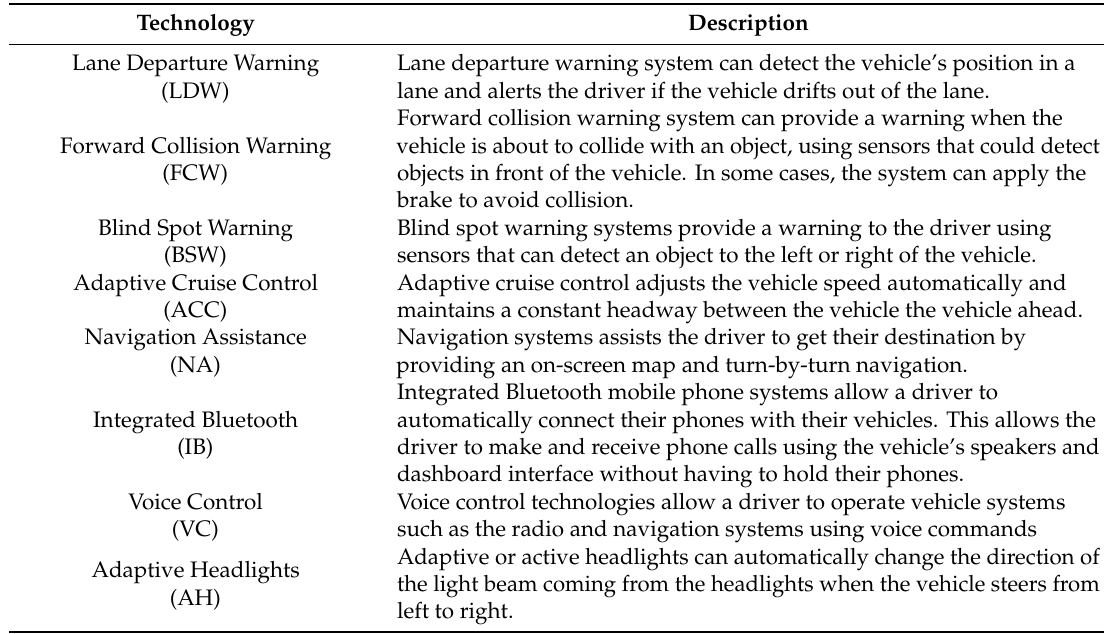
Table 2. Description of In-Vehicle